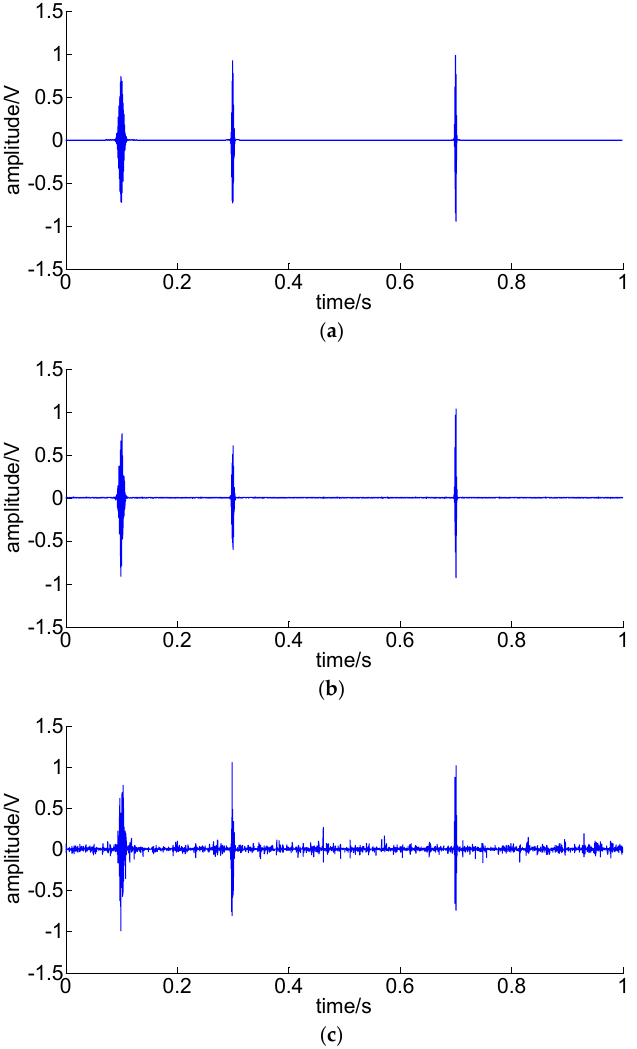
Figure 6. Enhanced signals using the filtered TEO: ( a ) S 1 : noise-free signal; ( b ) S 2 : noisy signal, SNR = − 3.16 dB; ( c ) S 3 : noisy signal, SNR = − 8.75